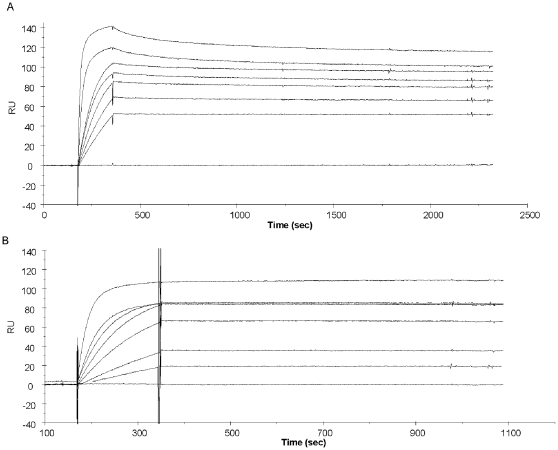
Kinetic analyses of cTA12 and mTA12 binding to Fc-BoNT/A1 by SPR.mTA12 was directly immobilized on a sensor chip at 200 RU (A), and cTA12 was captured at 150 RU using a sensor chip prepared with immobilized anti-human antibody (B). Fc-BoNT/A1 (range 0.8 to 20 nM) was injected at 50 µl/min for 3 min (association phase). Dissociation was monitored over a period of 30 min before the chip was regenerated with 10 mM glycine pH 2. BiaEvaluation Software 3.2 was used to calculate kinetic constants with the Langmuir 1∶1 model fit.